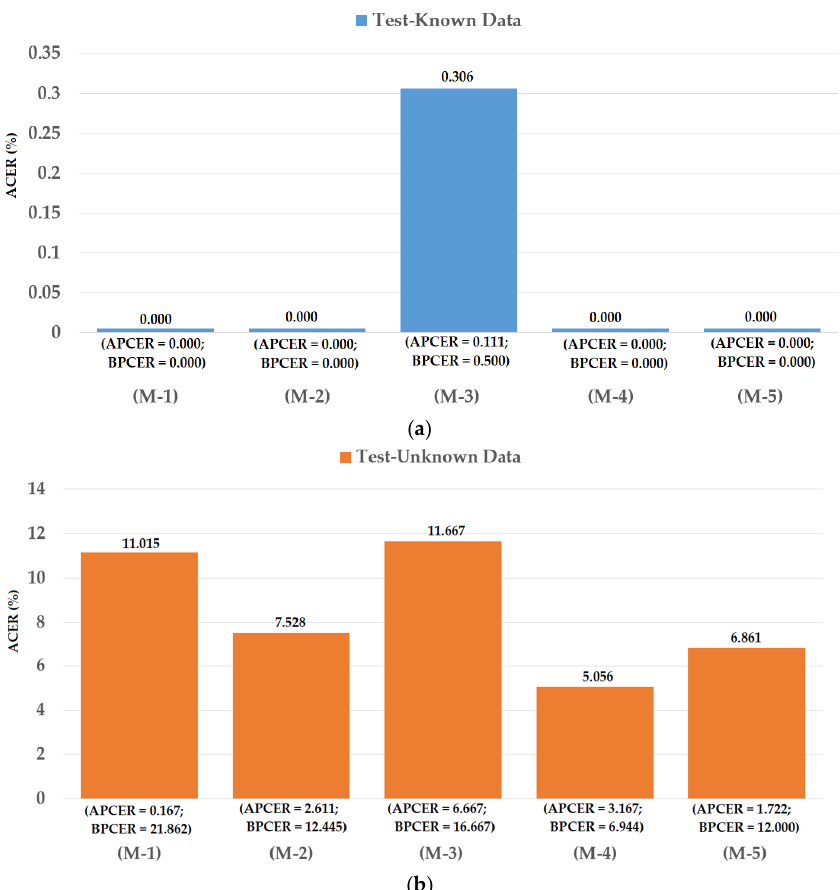
Figure 14. Detection errors of various iPAD methods using the second training-testing division method on ND2015 dataset: ( a ) Using Test-Known dataset; and ( b ) Using Test-Unknown dataset. Note: (M-1) Using CNN as Classifier; (M-2) Using CNN Features with PCA and Polynomial SVM Kernel; (M-3) Using MLBP Features with PCA and Polynomial SVM Kernel; (M-4) Using Feature Level Fusion with PCA and Polynomial SVM Kernel; and (M-5) Using Score Level Fusion with PCA and (Linear–Polynomial) SVM